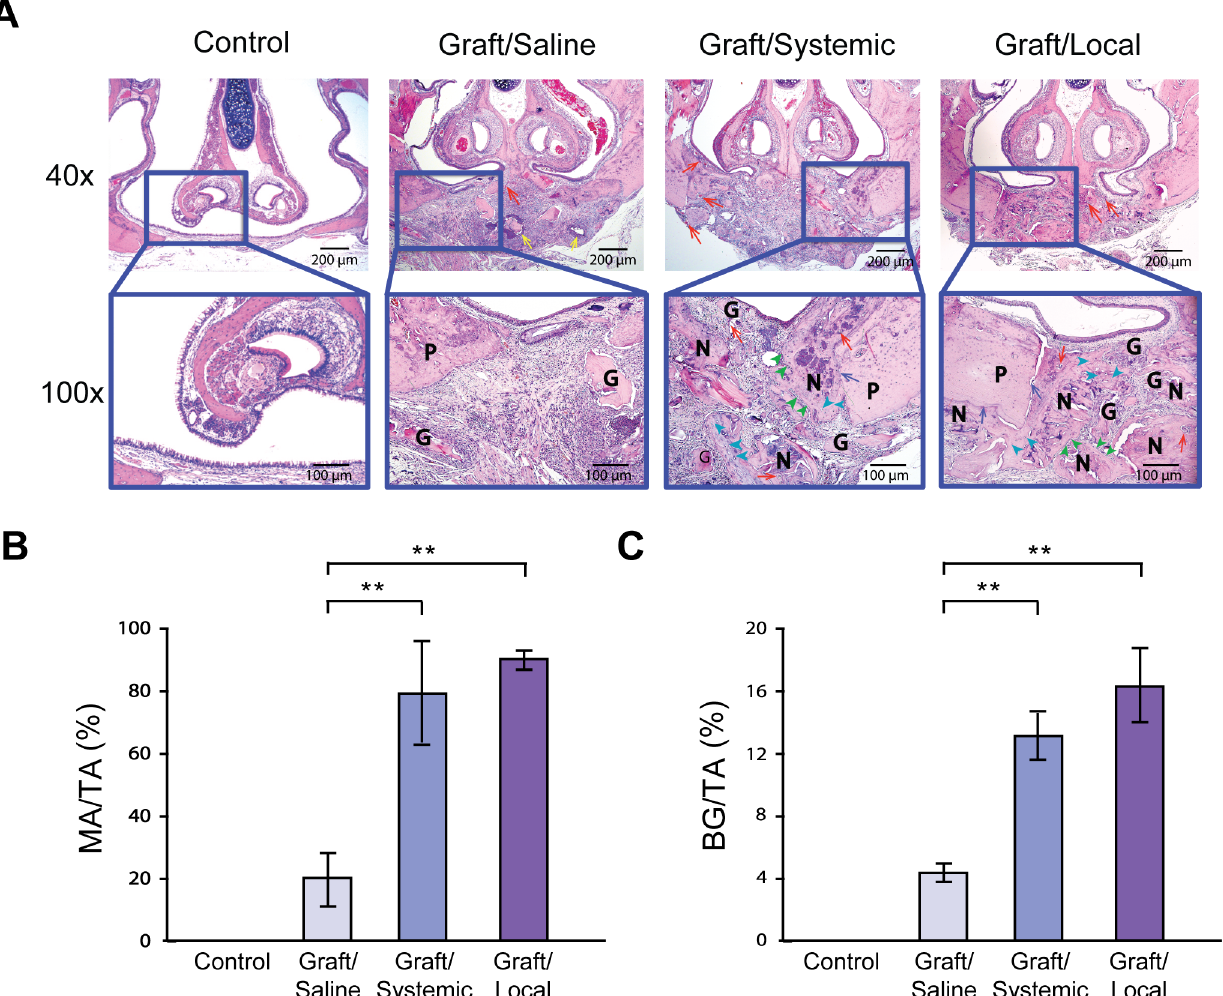
Fig 3. Histomorphometric analysis. (A) H&E stained coronalsections at 40x and 100x magnifications of all four groups of rats G : graft, P : palatal bone, N : new bone, red arrows: blood vessels aroundbone graft particles, yellow arrows: acute inflammation, blue arrows: bone integrationwith defect margins, green arrowheads: osteoblasts, light blue arrowheads: osteocytes. (B) Quantifications of bone area/total tissue area (MA/TA) for each group using an image analysissoftware (AdvancedSPOT 4.6, Macomb County, MI). (C) Quantification of bone graft/ total tissue area (BG/TA) for each group using AdvancedSPOT 4.6 software. * = p < 0.05, ** = p < 0.01.